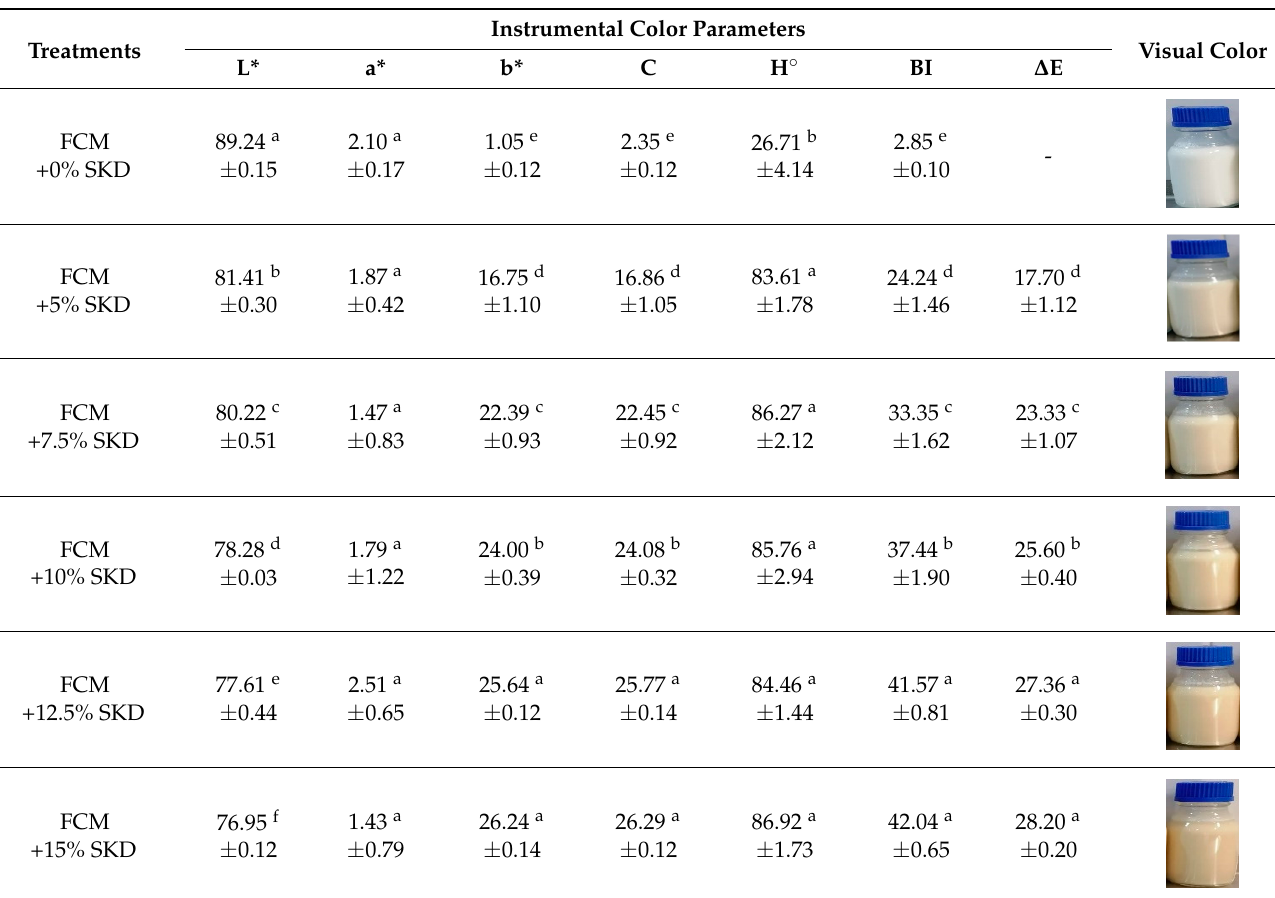
Table 5. Instrumental and visual color analysis of fermented camel milk (FCM) and FCM fortified with Sukkari date (SKD) palm, (mean ± SE), n = 6.